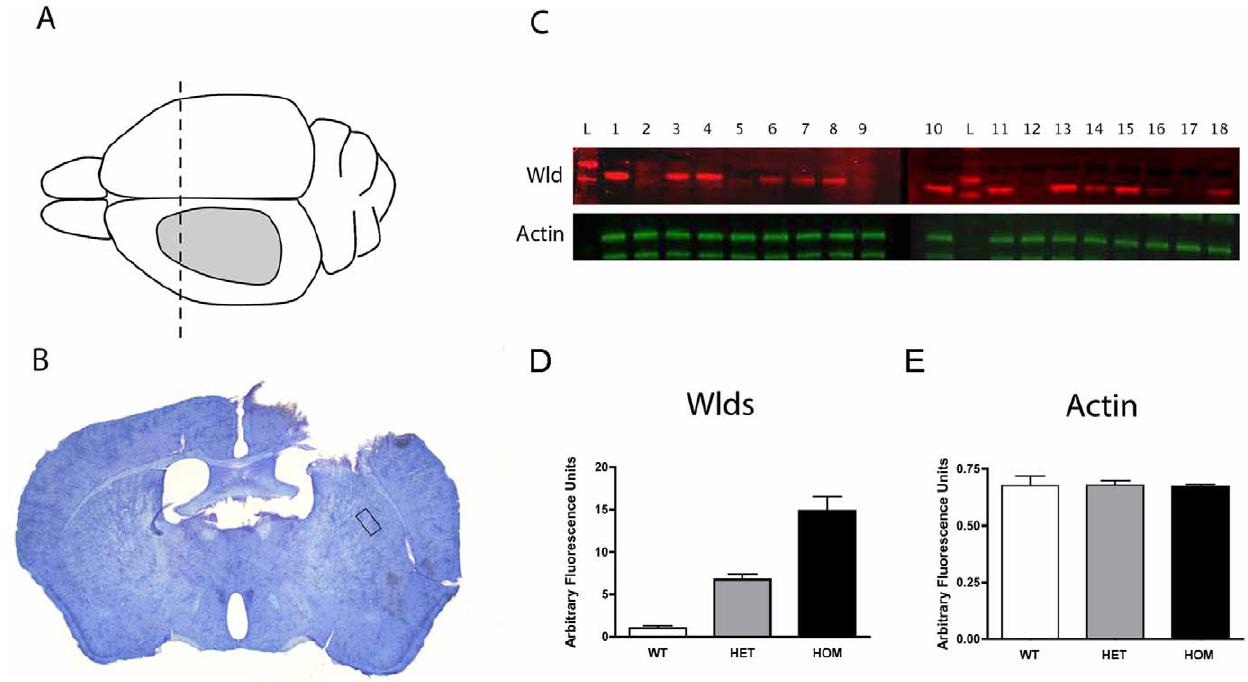
Figure 1. Cortical lesion model for initiating synaptic degeneration in the striatum of wild-type, heterozygous Wld S and homozygous Wld S mice. A/B – Schematic diagram of the mouse brain viewed from above (A), showing the extent of cortical lesion produced (grey area). The dotted line in panel A represents the level of brain shown in coronal section in panel B (note the lesion to the left cortex). The box in panel B shows the region of striatum selected for ultrastructural experiments. C – Quantitative fluorescent western blotting of protein extracted from tail tips was used to confirm the genotype of experimental mice generated from heterozygous Wld S ( + / 2 ) breeding colonies. Example blots show Wld S protein levels (red; labelled with the Wld-18 antibody specific for Wld S protein) and levels of actin loading control (green) in tail tips from 18 mice. 2 membranes are shown side by side with randomly arranged samples from individual mice numbered 1–18. A molecular weight marker is also shown (L). Lanes numbered 2,5,9,12 and 17 show wild-type mice (no Wld S protein present), lanes 6,7,8,14,16 and 18 show heterozygous Wld S mice (intermediate levels of Wld S protein present), and lanes 1,3,4,10,11,13 and 15 show homozygous Wld S mice (high levels of Wld S protein present). D/E – Bar charts (mean 6 SEM) showing quantification of fluorescent western blots (see methods) shown in panel C (pooled to give a mean value for each genotype), confirming that heterozygous Wld S mice had approximately half the expression levels of Wld S protein observed in homozygous Wld S mice (D), whilst levels of actin loading control remained constant (E) across mice of all genotypes. N=5 wild-type mice, 6 heterozygous Wld S mice & 7 homozygous Wld S mice.